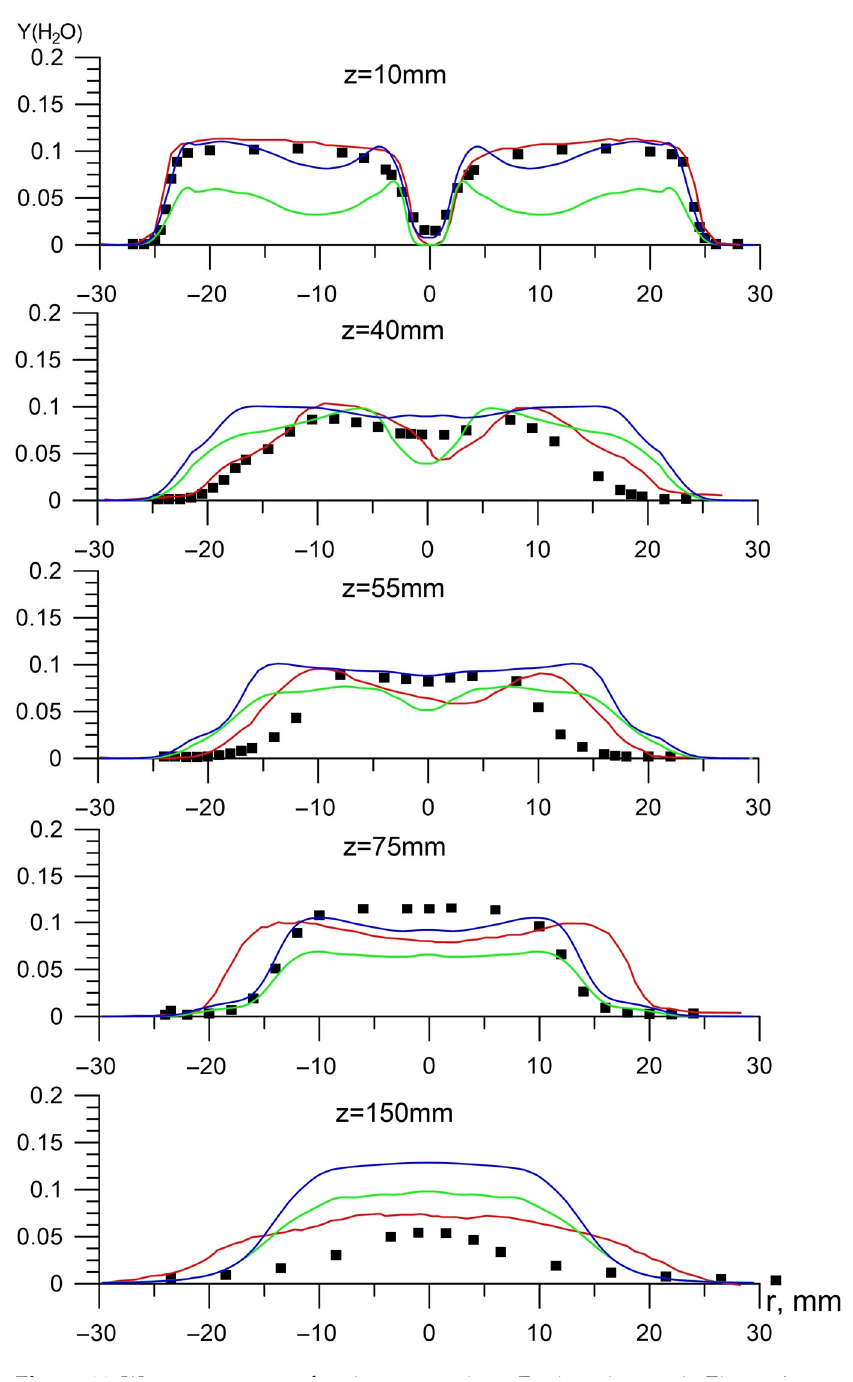
Figure 11. Water vapor mass fraction comparison. Designations as in Figure 6.